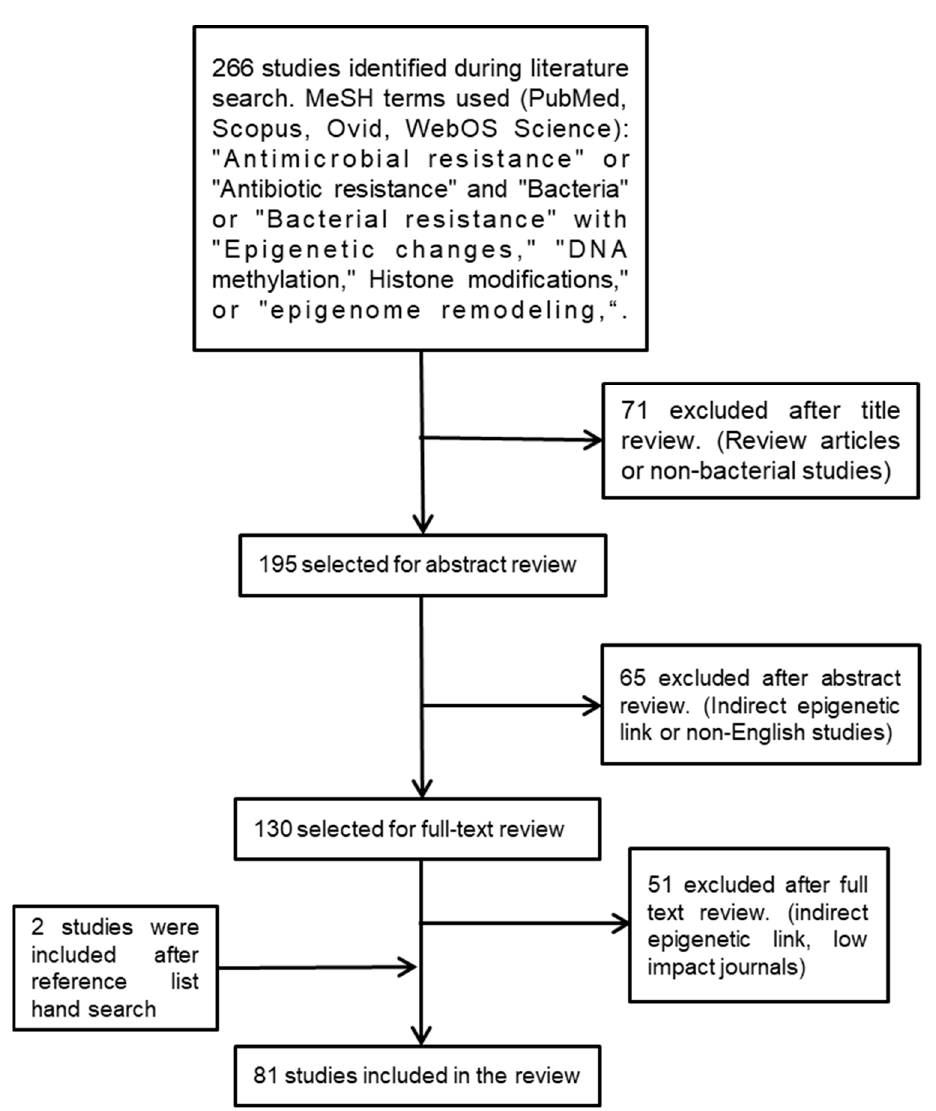
Figure 1. Flowchart outlining the strategy employed to identify the relevant